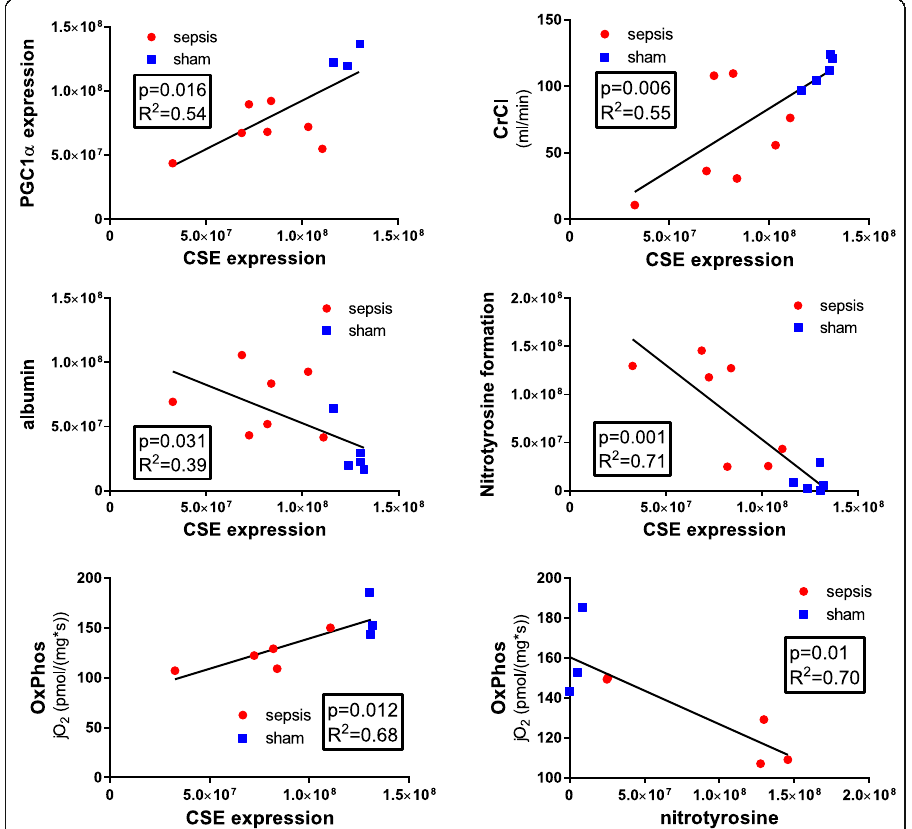
Fig. 4 Mathematical correlations of PGC1 α expression, kidney function (CrCl), albumin extravasation, nitrotyrosine formation, mitochondrial activity to CSE expression, and mitochondrial activity to nitrotyrosine formation. High R 2 values might in some cases rather be due to inter-group differences than correlations between the parameters per se; thus, R 2 values for (unpooled) separate groups are given in Additional file